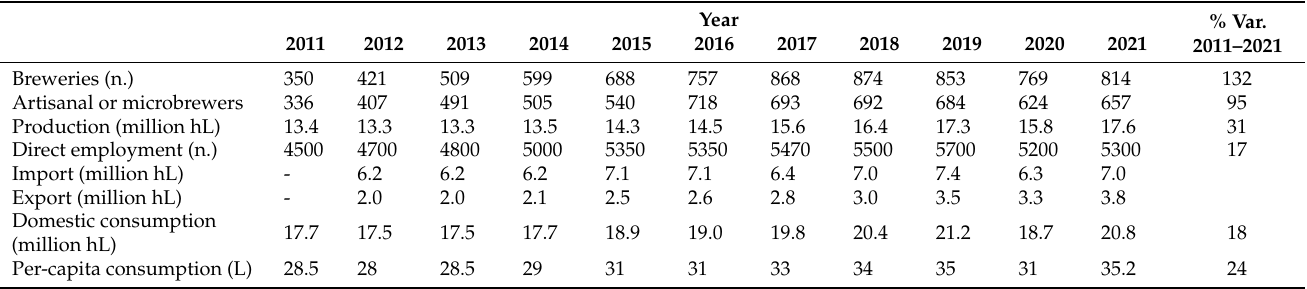
Table 1. Italian beer industry